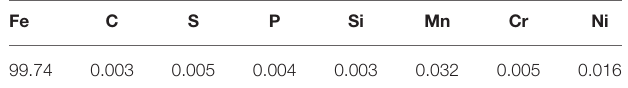
TABLE 3 | Elemental composition of Fe sample (mass fraction, %).